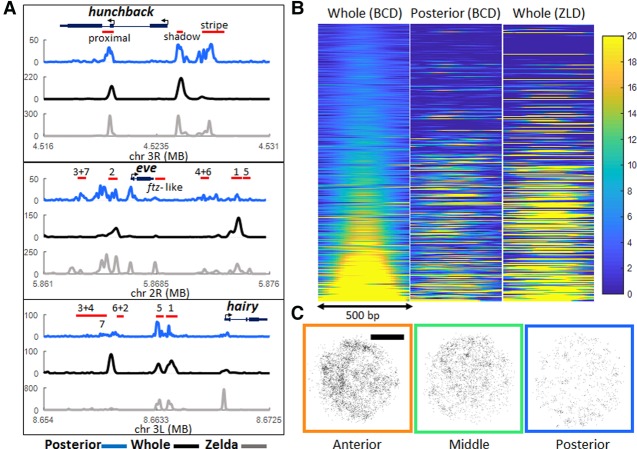
ZLD mediated BCD binding in the posterior embryo. (A) Posterior third (blue) and whole embryo (black) BCD and whole embryo ZLD (gray). ChIP-seq signal-normalized reads at the hunchback, eve, and hairy gene loci. Red bars show known enhancers as annotated in the RedFly database; for eve and hairy, they are numbered according to the stripes that they are thought to regulate. (B) Heat map representation of normalized BCD ChIP-seq reads (first two panels) and ZLD ChIP-seq reads (third panel) in a 500-base-pair window centered on BCD peaks called in the whole-embryo data and sorted according to increasing signal of the whole-embryo data; a total of 2145 peaks is shown, and colors indicate enrichment over the background (blue), with all plots displayed on the same scale. (C) Examples of the spatial distribution of all detected bound molecules in nuclei along the A–P axis in ZLD embryos. Bar, 2.5 µm. A loss of clustering is apparent compared with the distributions shown in Figure 2B.